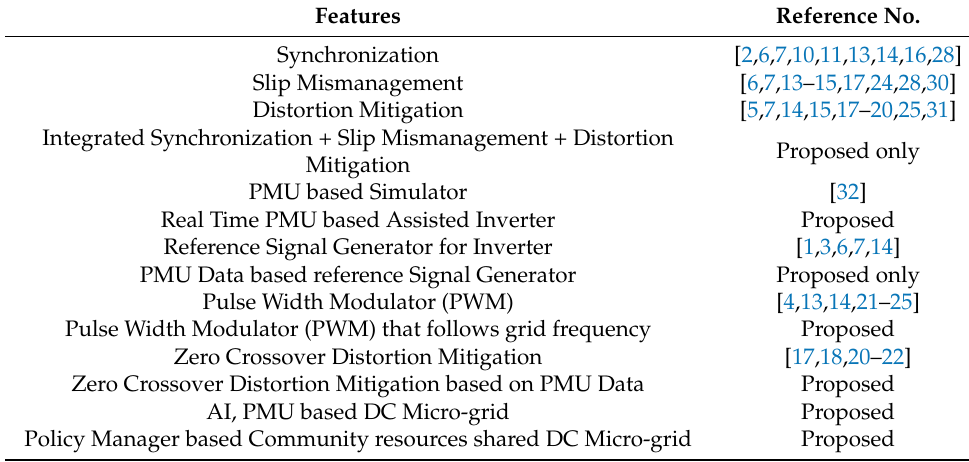
Table 1. Proposed Approach in View of Prior Art.